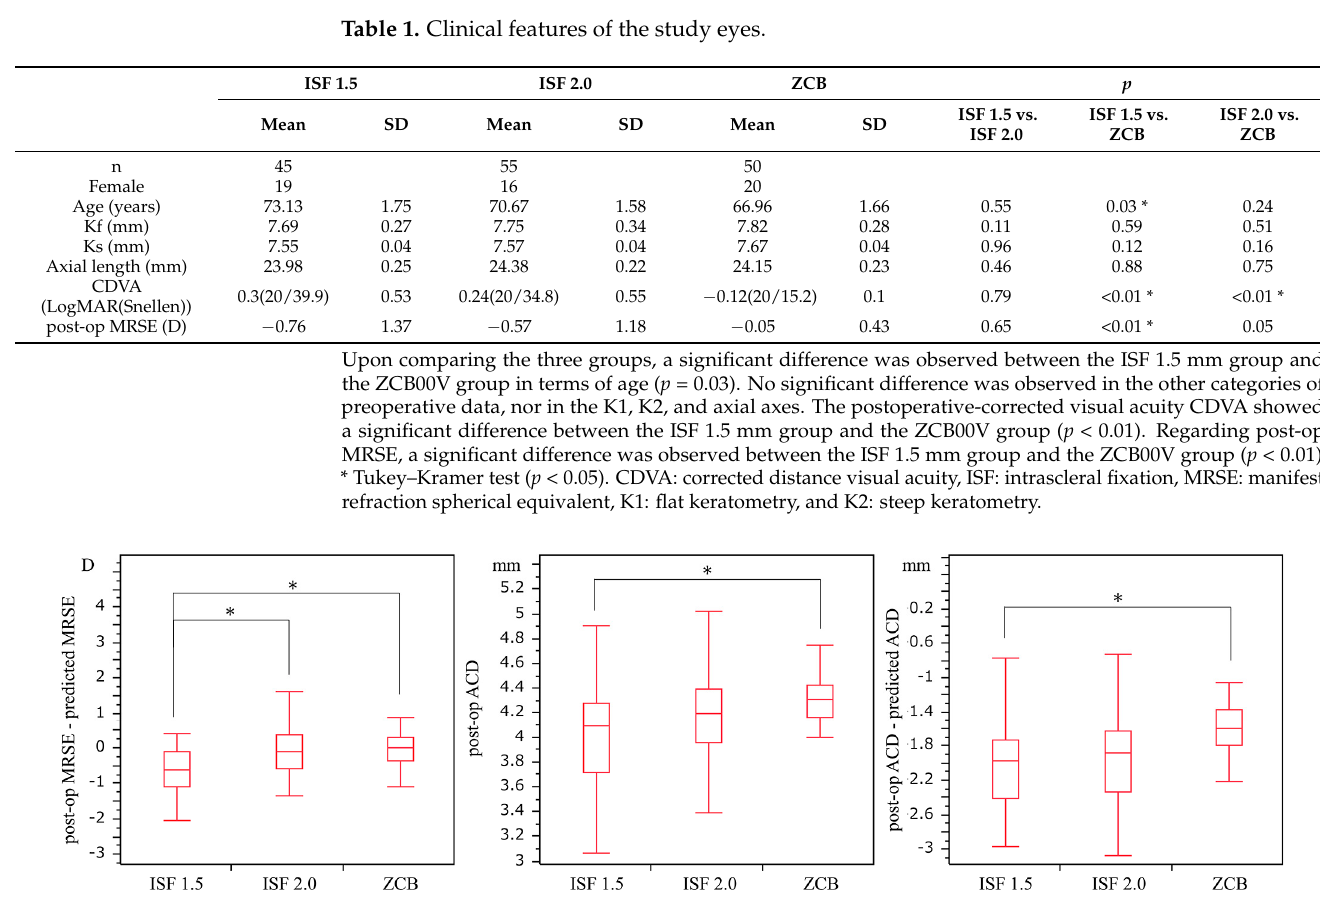
Figure 1. Refraction error and anterior chamber depth (post-op ACD) by fixed position. Significant differences in the post-op MRSE—predicted MRSE were found between the ISF 1.5 and ISF 2.0 groups as well as between the ISF 2.0 and ZCB groups ( p = 0.01 and p = 0.01). There were also significant differences in the post-op ACD between the ISF 1.5 and the ZCB groups ( p < 0.01). Further, there were significant differences in the post-op ACD—predicted ACD between the ISF 1.5 and ZCB groups as well as between the ISF 2.0 and ZCB groups ( p < 0.01 and p < 0.01). ACD: anterior chamber depth, ISF: intrascleral fixation, and MRSE: manifest refraction spherical equivalent. * Tukey-Kramer test, p < 0.05 . Table 1. Clinical features of the study eyes.